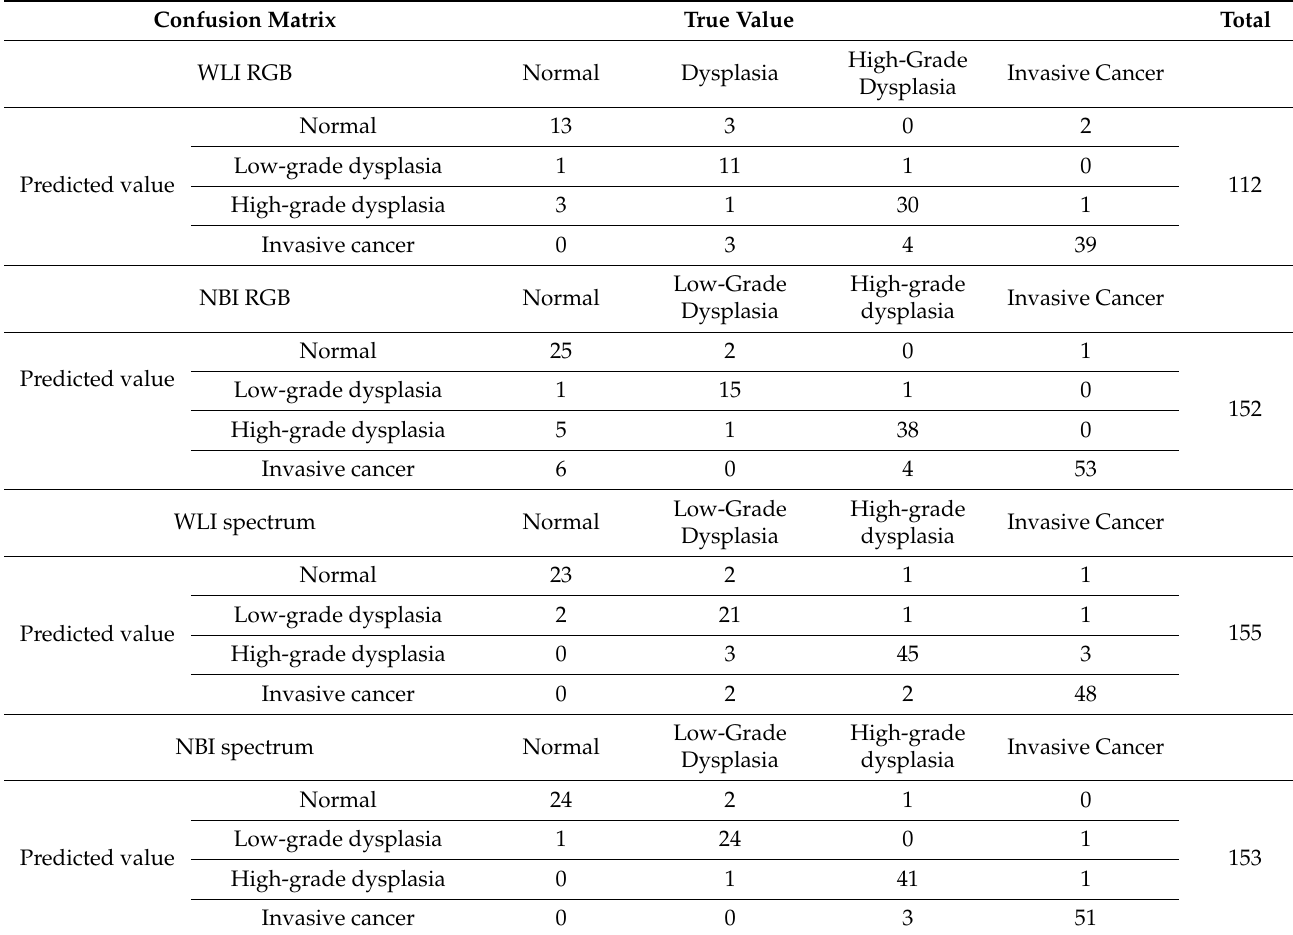
Table 2. Confusion matrix statistics table of RGB image and spectrum data test results, which compares the esophageal cancer spectrum data test and the test results using RGB esophageal cancer